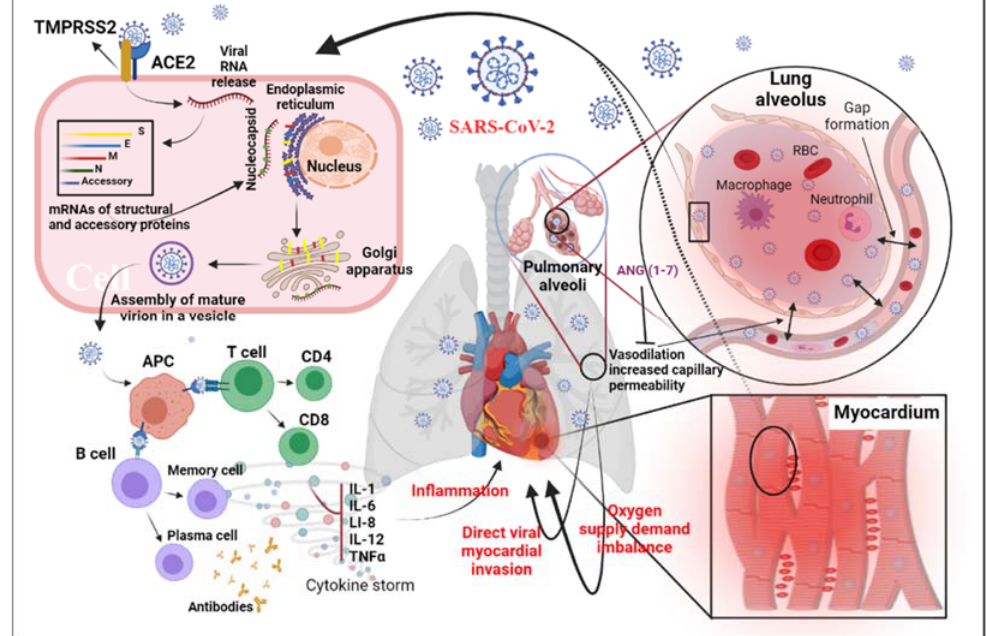
Figure 1. Diagram of potential physiological mechanisms of MI related to SARS ‐ CoV ‐ 2: This figure shows the proposed mechanisms of MI related to SARS ‐ CoV ‐ 2 infection through direct viral infection, inflammatory factors, and/or imbalance of the oxygen supply caused by acute respiratory distress syndrome. Abbreviations: ACE2, angiotensin ‐ converting enzyme 2; S, spike; E, envelope; M, matrix/membrane, N, nucleocapsid; ANG, angiotensin; APC, antigen ‐ presenting cell; IL ‐ 1, interleukin 1; IL ‐ 6, interleukin 6; IL ‐ 12, interleukin 12; TNF ‐α , tumor necrosis factor alpha; TMPRSS2, transmembrane protease, serine 2.